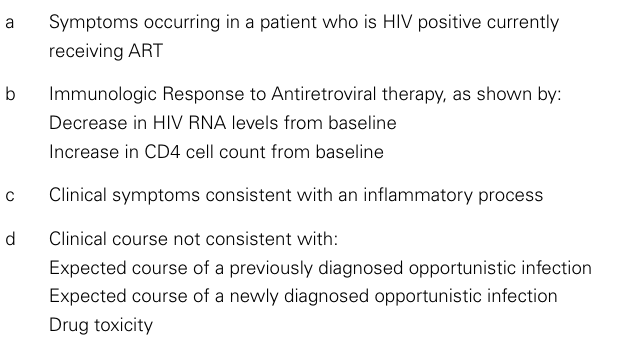
Table 1 |Working definition of IRIS (Shelburne et al., 2006)